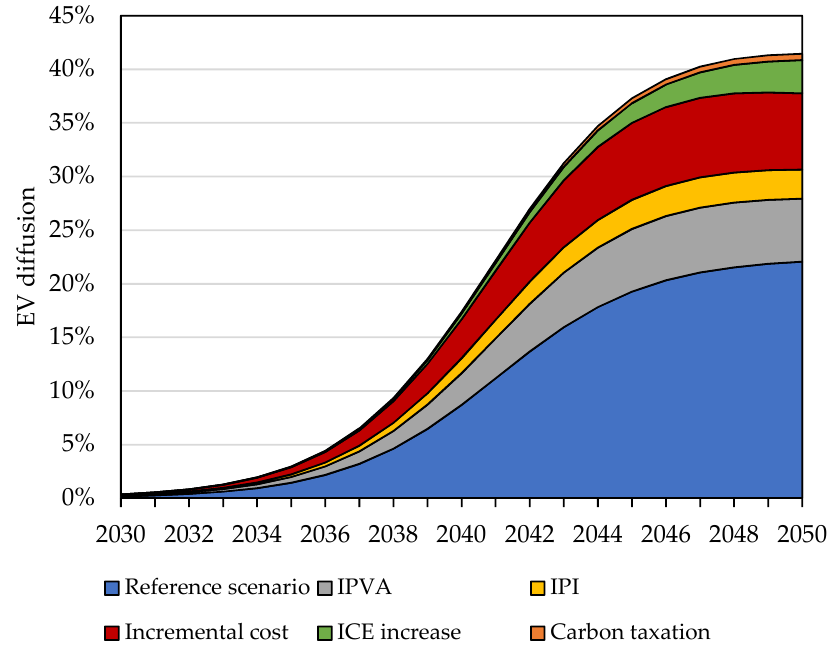
Figure 4. Effect of each policy instrument on the EV share in passenger car sales in Brazil ( S alt ), 2030 to 2050.